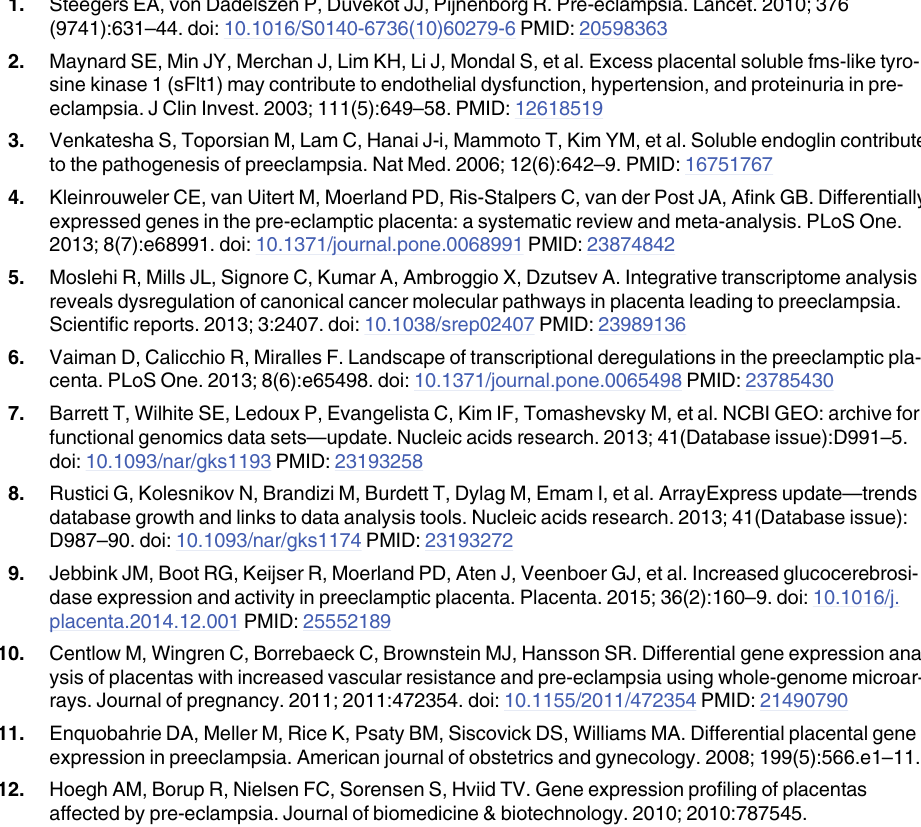
S3 Table. Pathway analysis (all significant pathways). S4 Table. Expression of meta-signature genes in placentas of different gestational ages. Indicated microarray samples were analyzed by the Gene Expression Barcode 3.0 and the resulting z-scores are shown. The z-score is the number of standard deviations above the mean expression signal of the unexpressed null distribution. An average z-score of (cid:4) 3 for a gene- specific probe has been labeled as being expressed in that